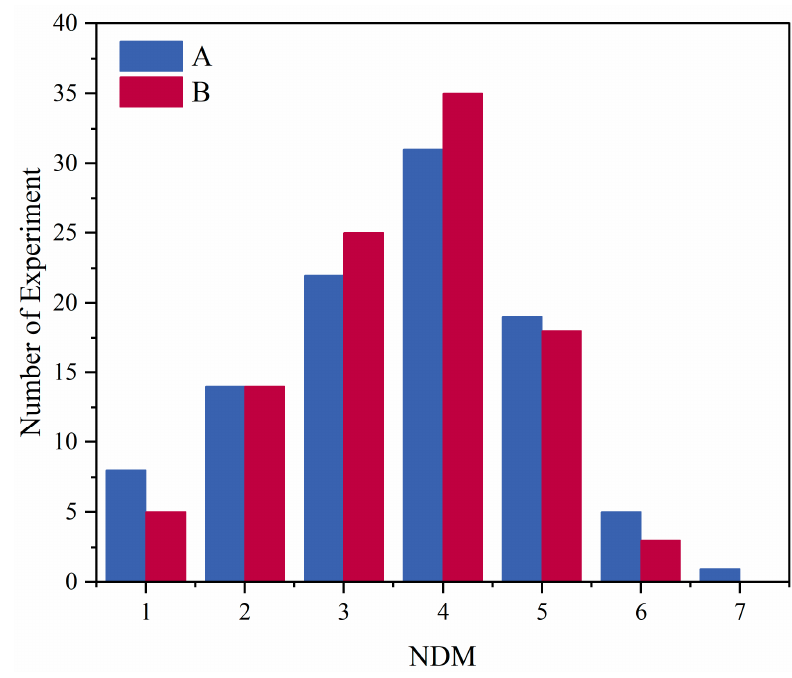
Figure 5. NDM in A and B ( t =